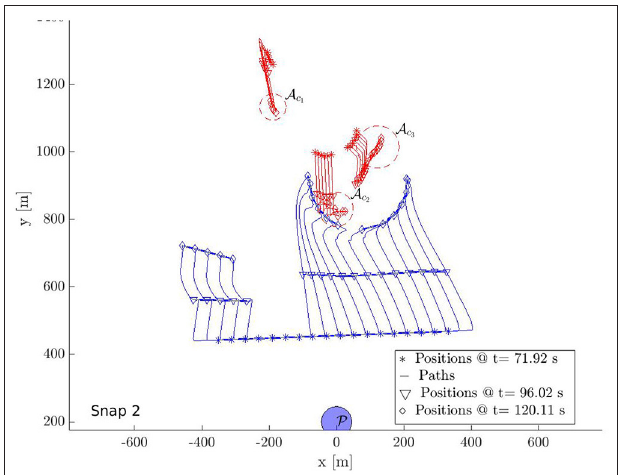
FIGURE 10 | Multi-Swarm StringNet Herding: Snapshot 2.